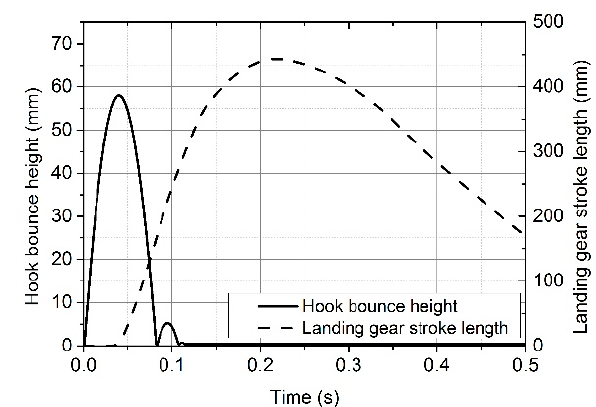
Figure 2. Curves of hook bounce height and main landing gear stroke